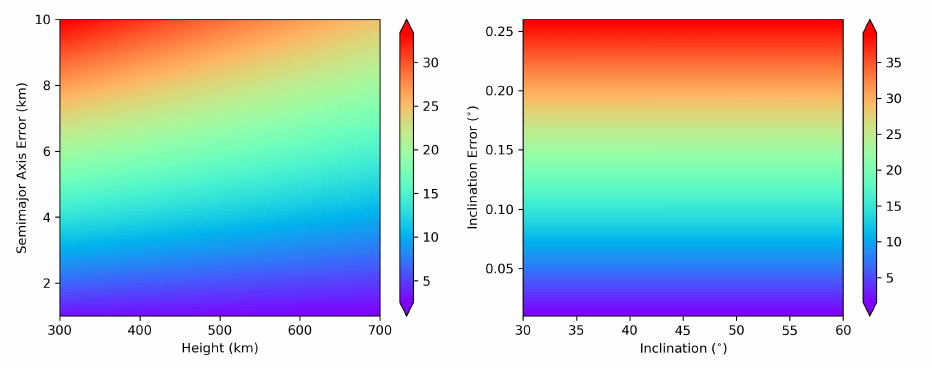
Figure 6. ∆ ρ with respect to the accuracy of the estimated orbital elements.